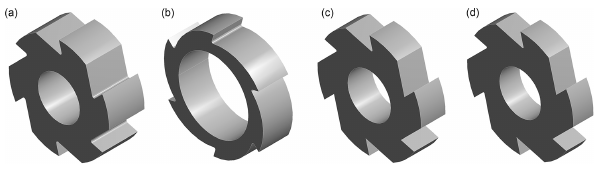
Figure 4. A ratchet 3D model, showing (a) ratchet 1, (b) ratchet 2, (c) ratchet 3 and (d) ratchet 4.